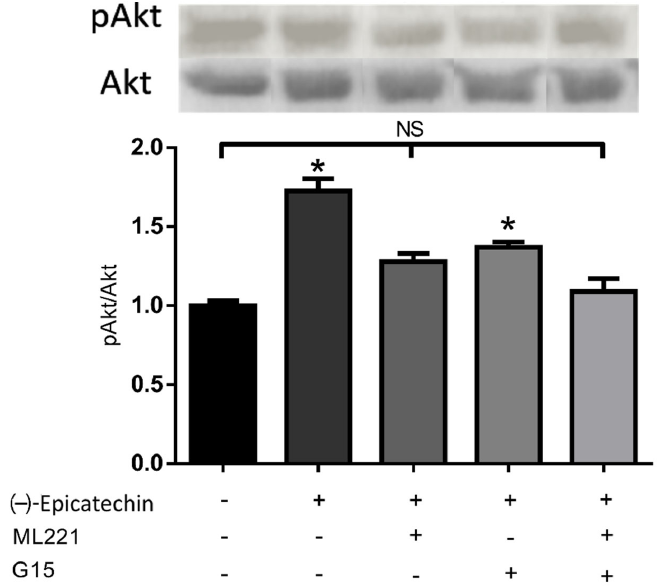
Figure 1. Acute effects (30 min) of EC on upstream Akt activation and the inhibition of these effects with G15 (GPER antagonist), ML221 (APLNR antagonist), and the combination of both. Each Western blot is representative of three independent experiments. Data are expressed as mean ± SD ( n = 3). * = p < 0.05, NS (nonsignificant).